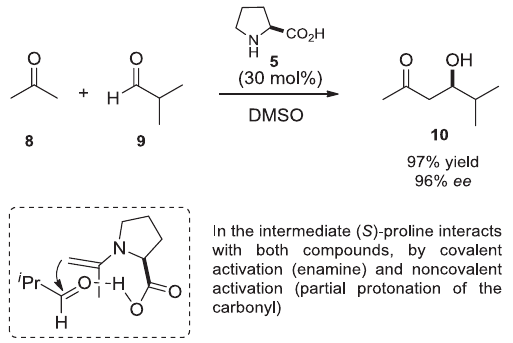
Figure 5. Direct aldol reaction catalyzed by ( S )-proline, see Ref.